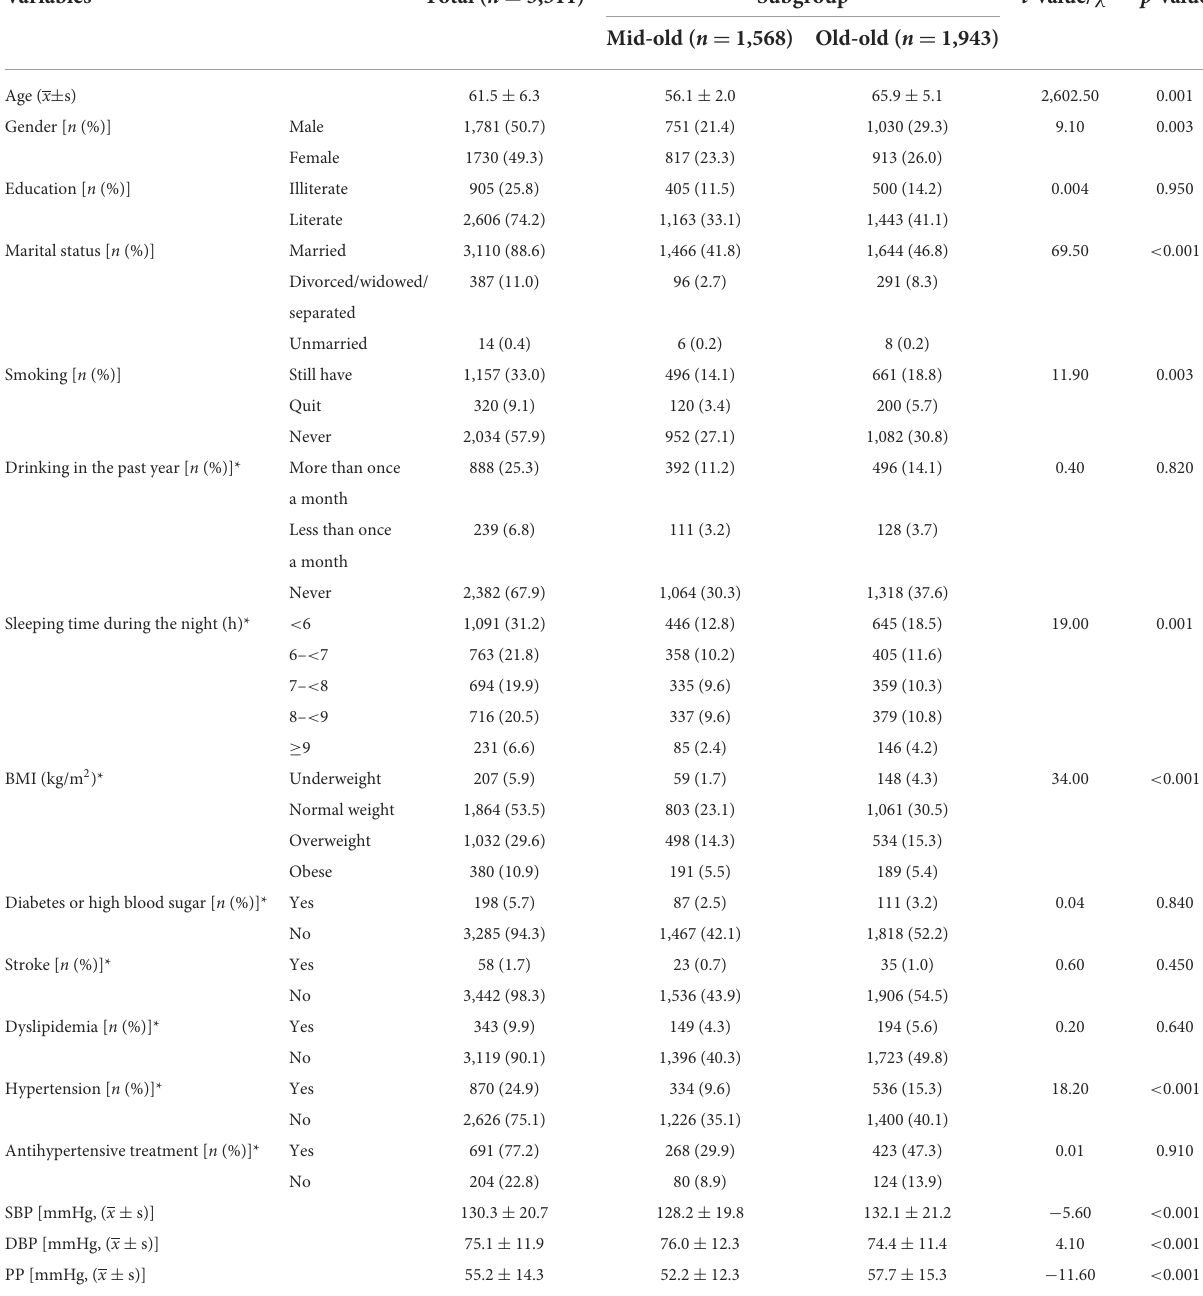
TABLE 1 Demographic characteristics of study population at baseline (Wave